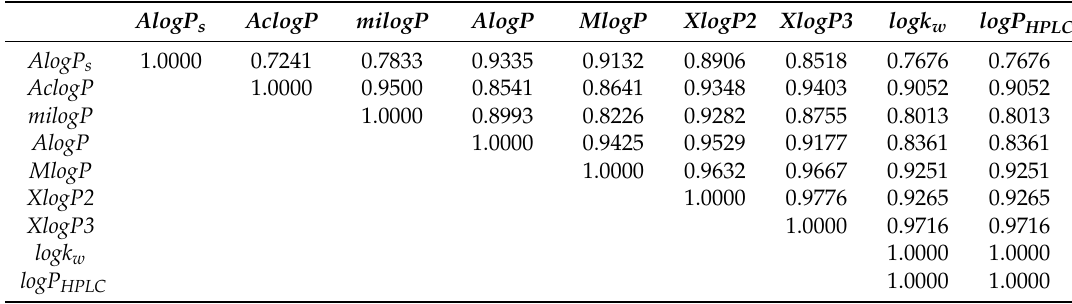
Table 3. The correlation matrix for logP calc vs. logP HPLC (group A: 4-benzoylthiosemicarbazides).